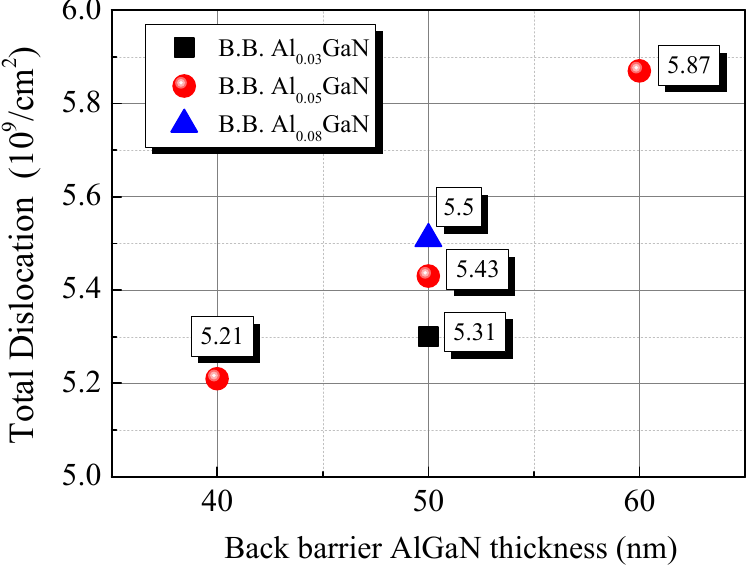
Figure 2. The total dislocation of AlGaN/GaN with AlGaN back barrier HEMT on MCz-Si